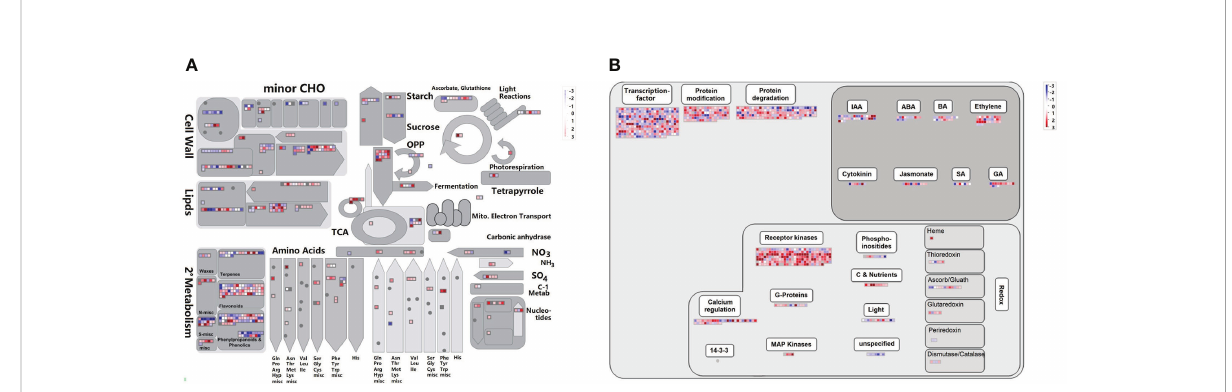
FIGURE 7 Overviews of cellular metabolism (A) and regulation (B) for DEGs. DEGs indicates differentially expressed genes. The individual small square indicates one DEG. The scale from -3 to +3 indicates the average FPKM normalized log2 transformed counts of